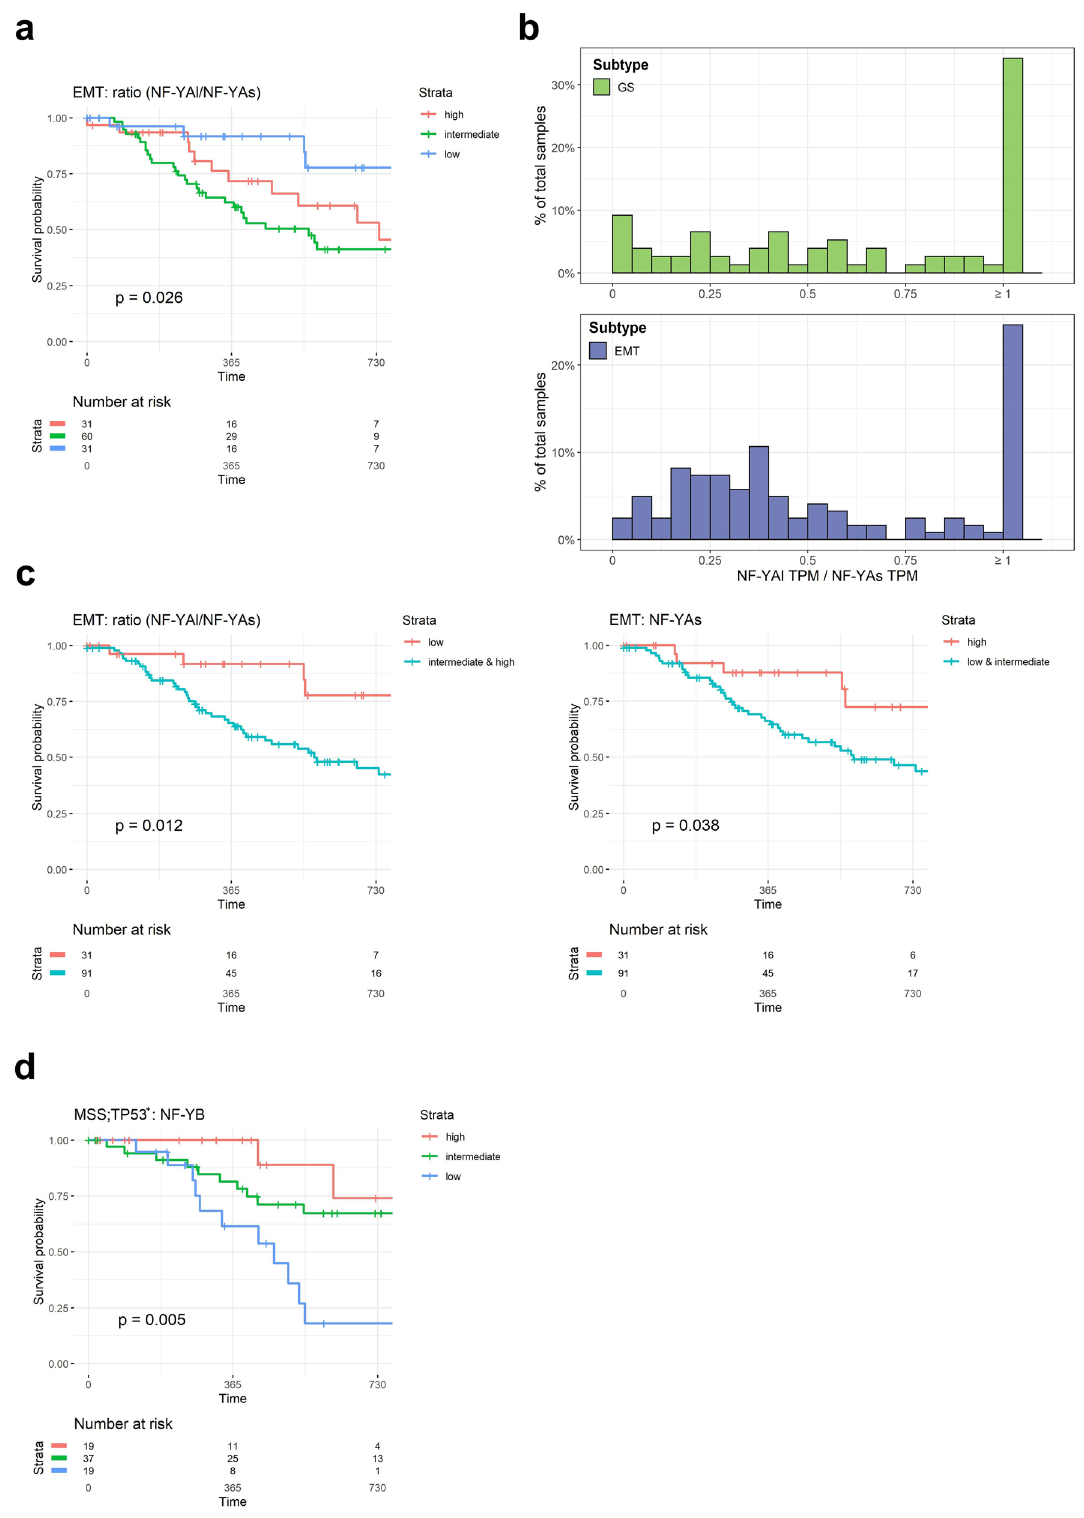
Figure 6. Clinical outcome of NF-Y expression according to the ACRG classification. ( a ) Progression-Free-Interval curves of survival probability of EMT tumors with stratification according to quartiles of NF-YAl/NF-YAs ratio (Intermediate, High and Low). We stratified all available tumors in the three groups according to the ratio levels: Low = first quartile, High = fourth quartile, and Intermediate for values included in the two middle quartiles. p values are calculated using the log-rank test. ( b ) Distribution of NF-YAl/NF-YAs ratios in the TCGA GS (Upper Panel) and ACRG EMT (Lower Panel) samples. The width of each bin was set to 0.05, and ratios equal to or greater than one were included in the last bin. ( c ) PFI curves in EMT tumors of NF-YAl/NF-YAs (Left Panel) and NF-YAs (Right Panel) stratified in Low and Intermediate/High values or High and Intermediate/Low, respectively. ( d ) Same as ( a ), except that the levels of NF-YB expression were correlated to prognosis in MSS;TP53 +